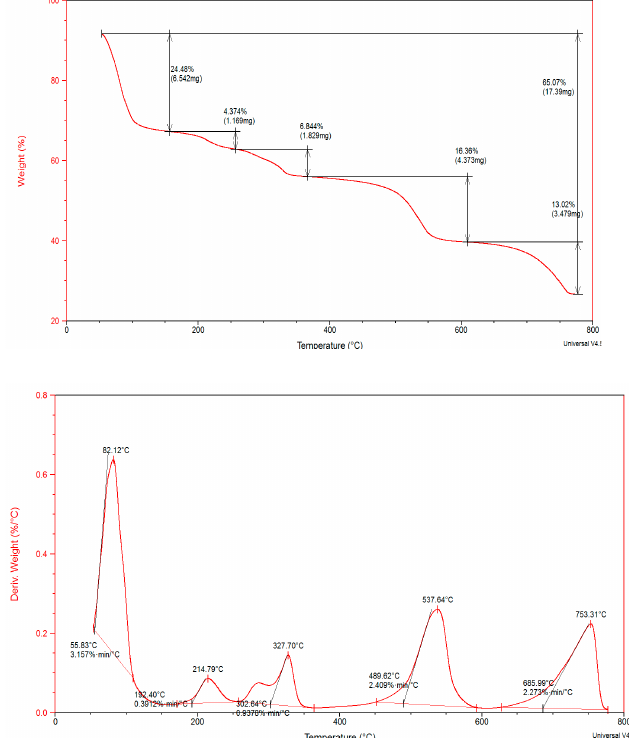
Figure 4. Thermal gravimetric analysis and differential thermal analysis of PCC.